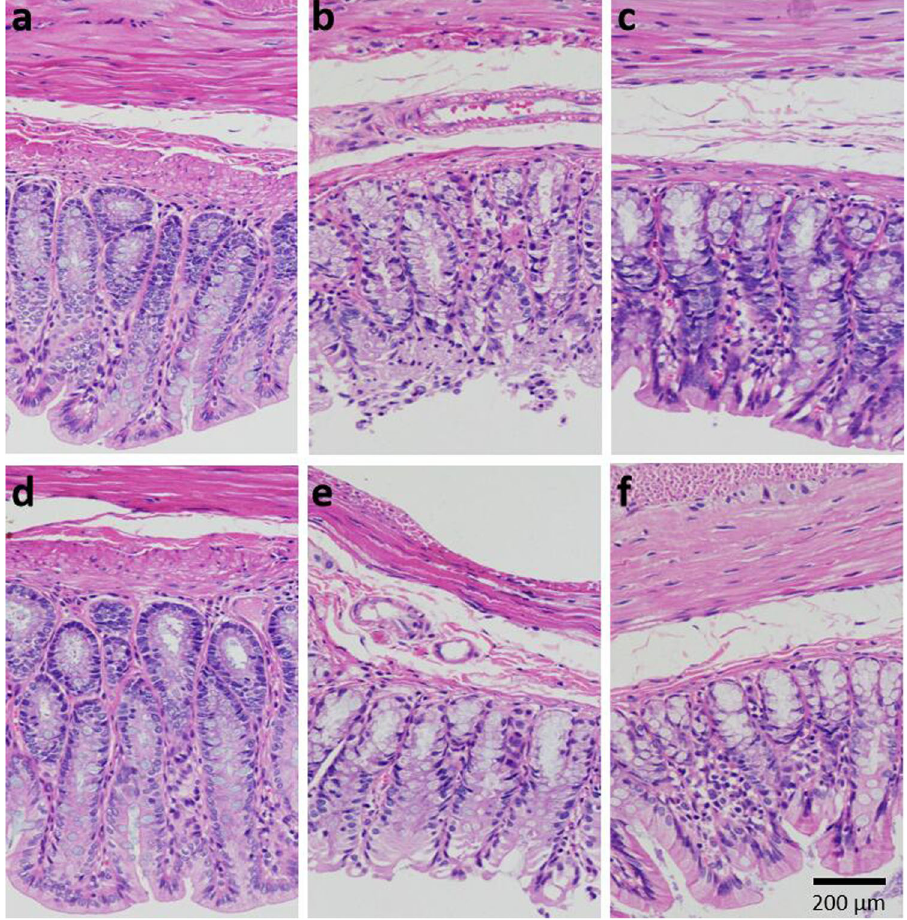
Fig. 6 Colonic structure of rats after 4-week intervention. a Normal; b Model; c SOD; d L-SOD; e SOD hydrolysate; f Positive control.